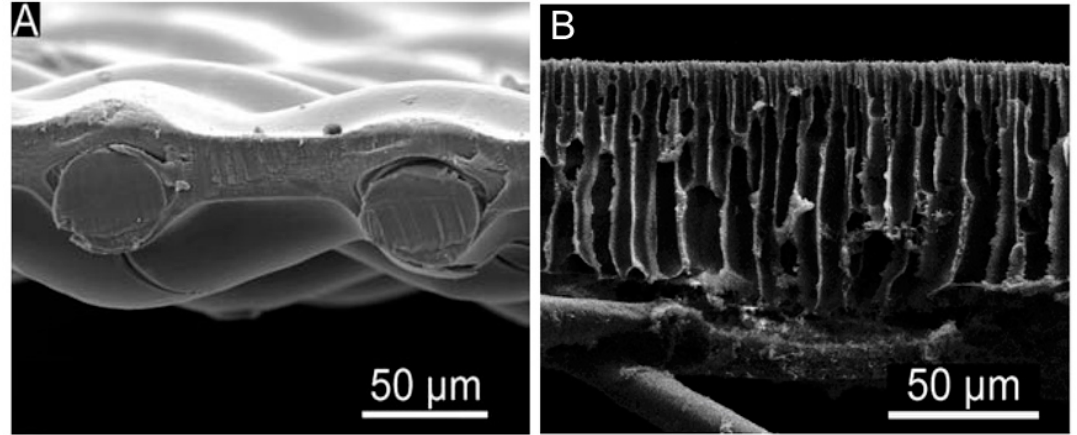
Figure 1. Cross-section SEM micrographs of ( A ) commercial CTA-HTI and ( B ) TFC membrane. Reproduced with permission from Yip, Tiraferri, Phillip, Schiffman and Elimelech [16], Copyright (1969) American Chemical Society.